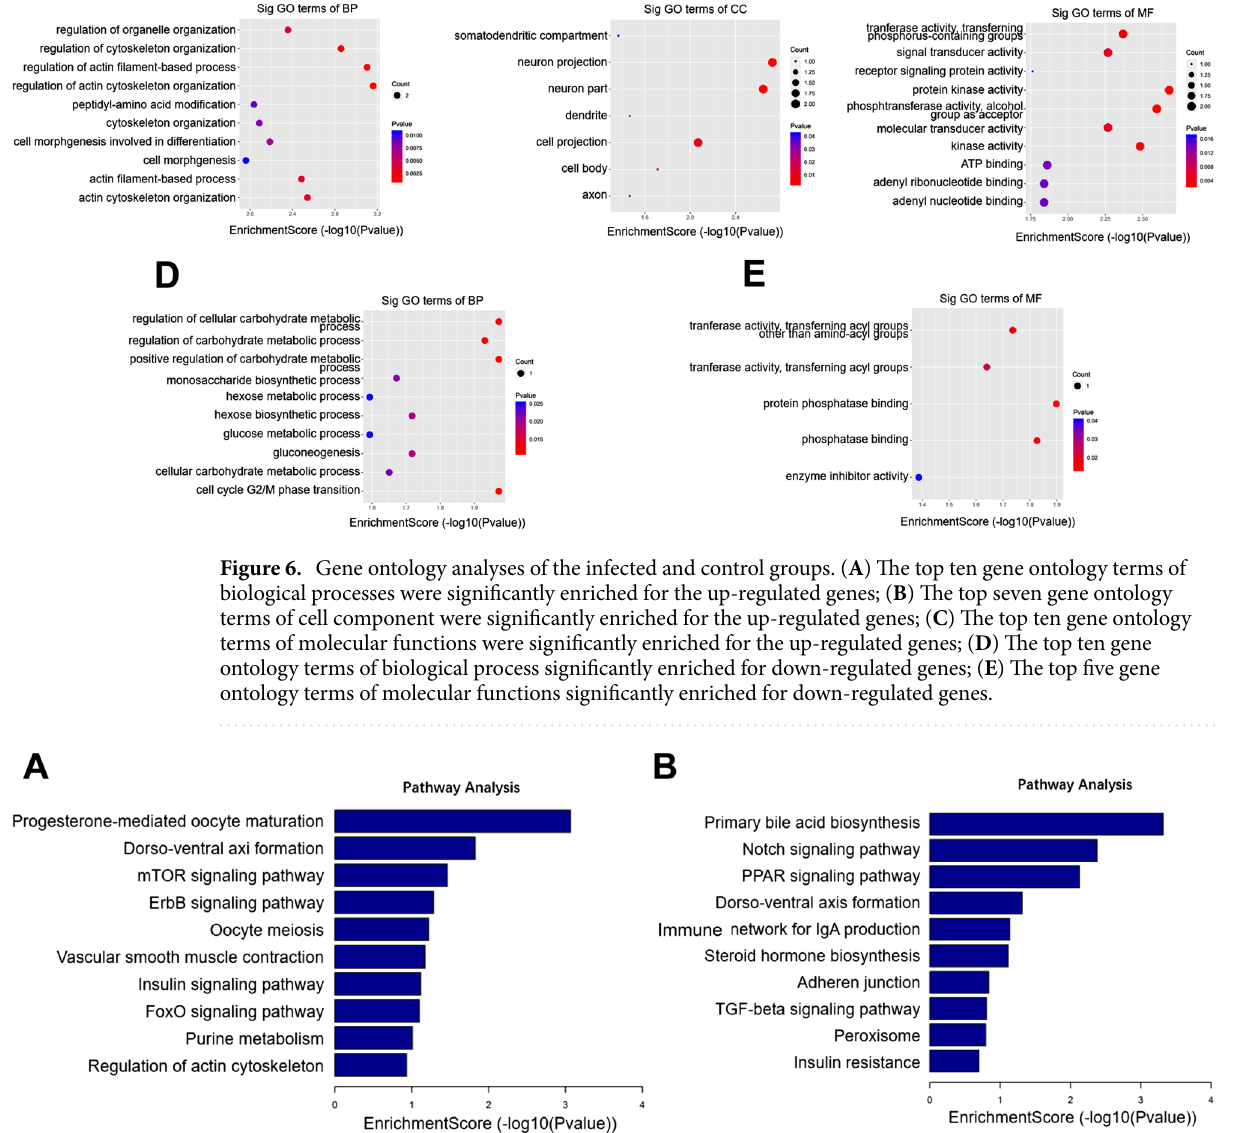
Figure 7. KEGG pathway analysis of differentially methylated m 6 A genes in circRNAs. ( A ) Bar plot showing the top 10 enrichment scores of significantly enriched pathways for up-methylated m 6 A genes in the infected group; ( B ) Bar plot showing the top 10 enrichment scores of significantly enriched pathways for down- methylated m 6 A genes in the infected